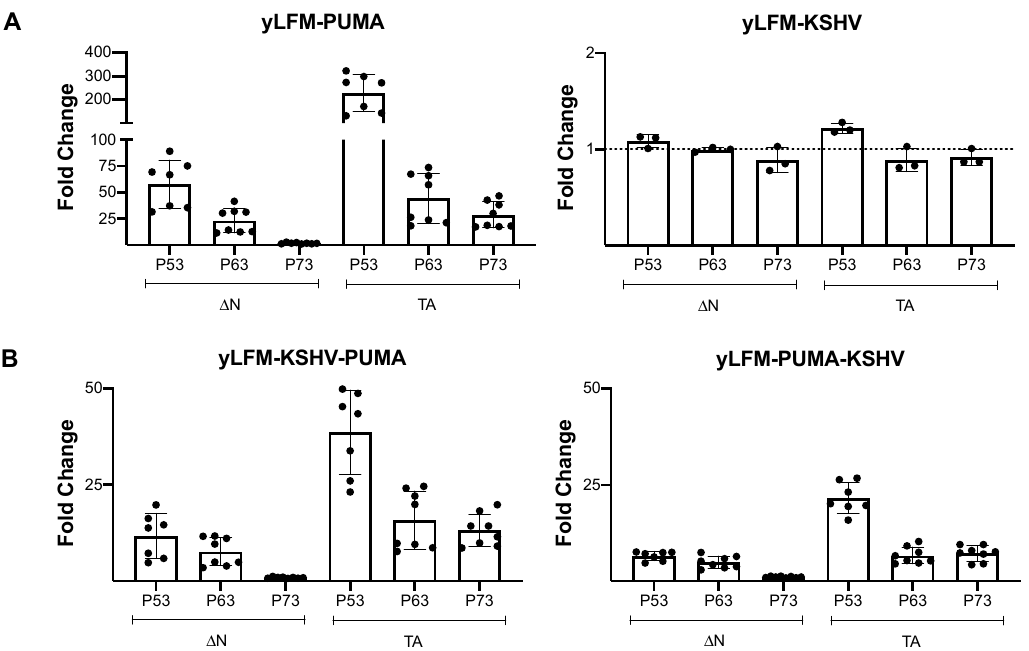
Figure 1. Fold change transactivation by wild-type P53 family proteins. Yeast cells expressing different P53 family isoforms by an inducible GAL1,10 promoter were grown for 8 h in Galactose 1% to evaluate their transactivation ability. ( A ) Evaluation of wild-type P53, P63, and P73 ( ∆ N variants: ∆ N40P53 α , ∆ NP63 α , and ∆ NP73 α ; TA variants: full-length P53, TAP63 α , and TAP73 α ) transcriptional activity as fold change over the empty vector in presence of the P53 response element (RE) from the PUMA target gene (yLFM-PUMA) or a G4 prone sequence (yLFM-KSHV). ( B ) Evaluation of transcriptional activity as in panel A in the presence of the G4 prone sequence upstream (yLFM-KSHV-PUMA) or downstream (yLFM-PUMA-KSHV) of the P53 RE from the PUMA target